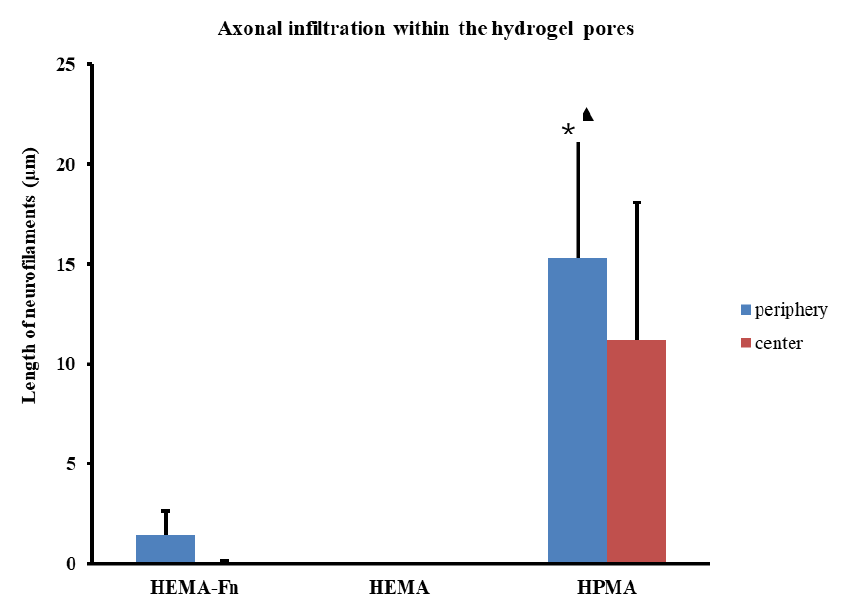
Figure 6. Comparison of axonal ingrowth within the three hydrogels. The total length of axons was assessed within the peripheral (blue bars) as well as the central (red bars) regions of the scaffold. The graph shows that the HPMA scaffold promoted statistically significant infiltration of axons within the pores of the scaffold compared to both HEMA hydrogels (* p < 0.05, (cid:78) p < 0.05). The graph shows that there were no axons within the HEMA scaffold, while the modification of fibronectin (HEMA-Fn) showed at least some axonal infiltration with the periphery and some even grew as far as the central parts of the scaffold. Data shown as mean and the error bars represent SEM. For statistical analysis, a one-way ANOVA test was